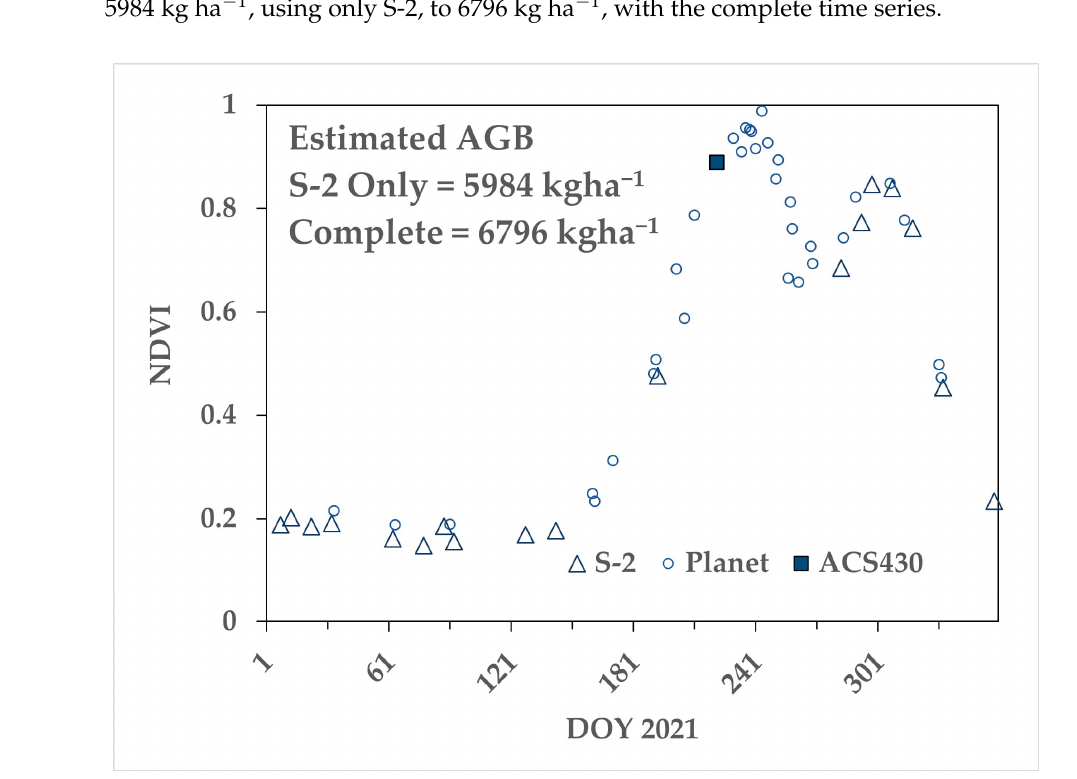
Table 5. Estimating the S-2 NDVI values using active optical measurements 1 .